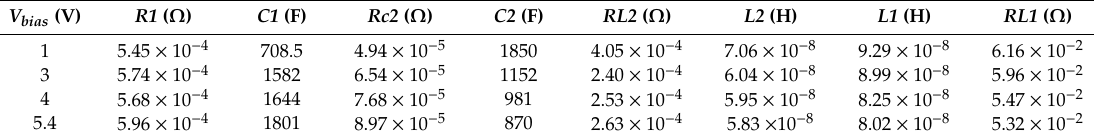
Table 3. Values of the electrical circuit elements for the different initial voltages in the cells.